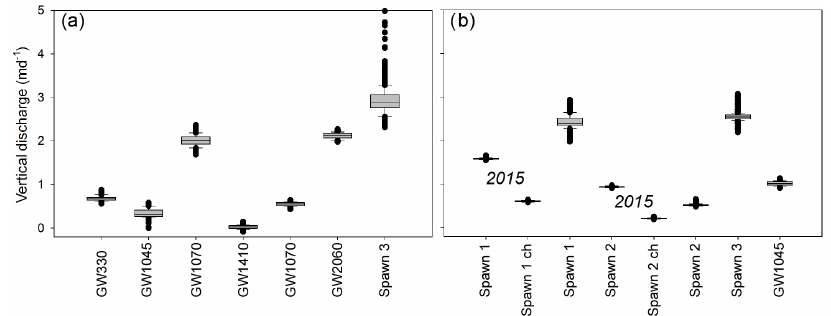
Figure 6. Summarizing box plots of sub-daily vertical groundwater-discharge rates modeled for the open-valley groundwater discharge and Spawn 3 bank locations for the 11 June to 13 July 2014 period are shown in panel (a) . Additionally, panel (b) displays discharge rates collected in Spawn and GW1045 locations directly against the cutbanks and farther out towards the channel (indicated by “ch”) for the 21 August to 13 September 2015 and 5 June to 9 July 2016